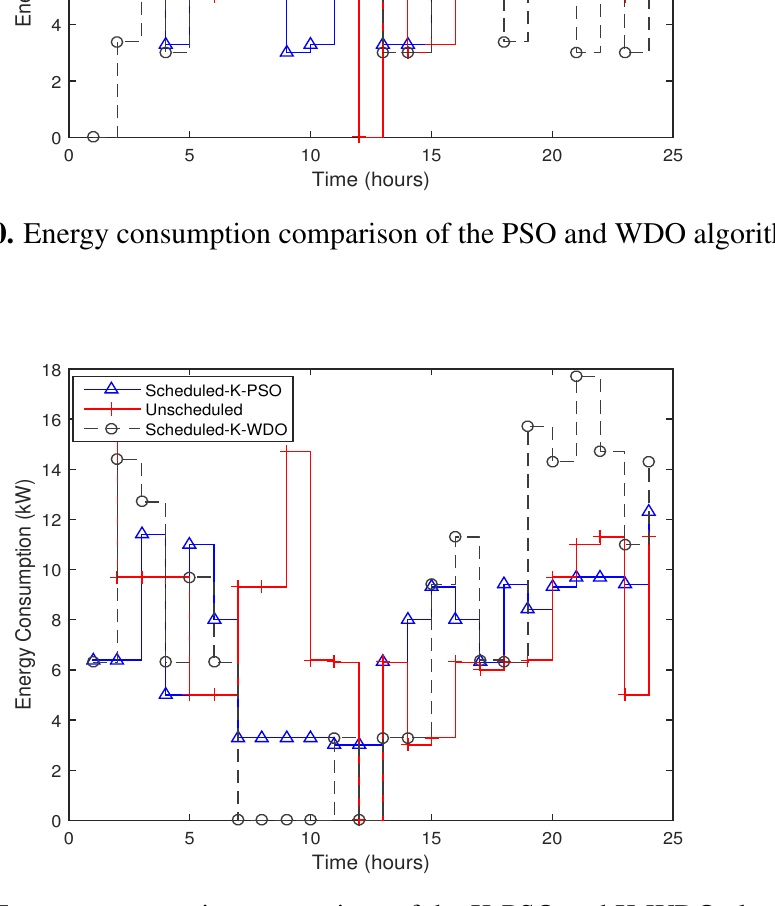
Figure 11. Energy consumption comparison of the K-PSO and K-WDO